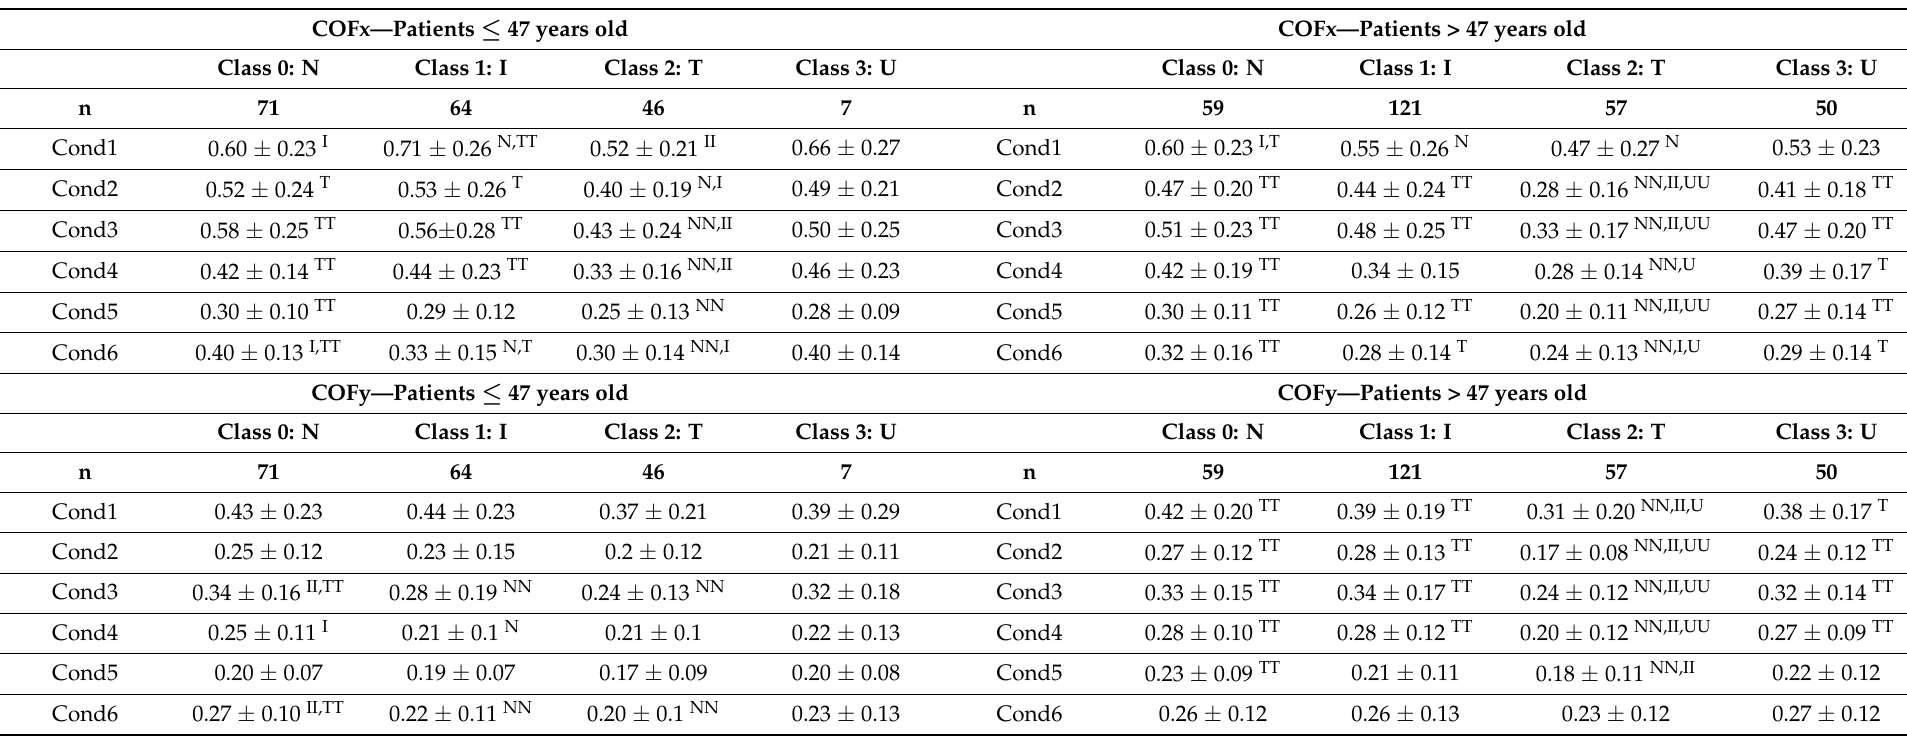
Mark of “N” means significant difference in comparison with Class 0: Normal Balance. Mark of “I” means significant difference in comparison with Class 1: Imbalance. Mark of “T” means significant difference in comparison with Class 2: TBI. Mark of “U” means significant difference in comparison with Class 3: UVW Right. Single character represents p -values < 0.05. Twin characters represents p -values <